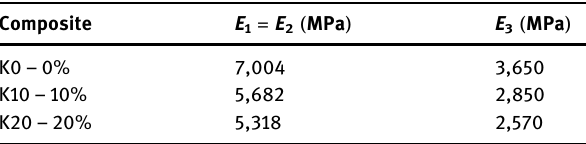
Table 6: Values of Poisson ’ s ratios for composites K0, K10 and